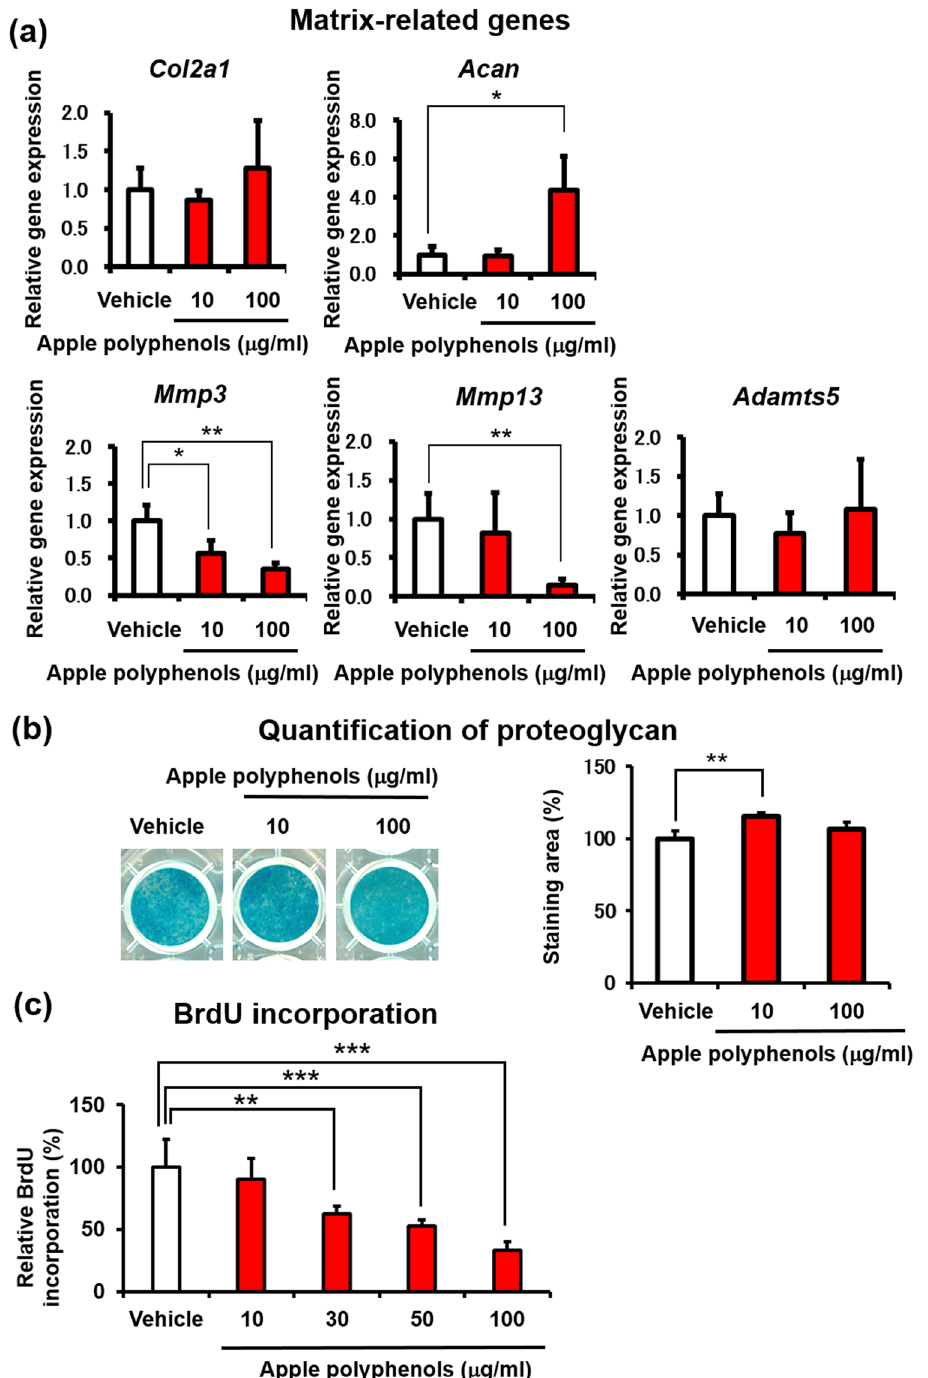
Figure 3. Apple polyphenols enhance proteoglycan synthesis in primary chondrocytes. Apple polyphenols were added to primary chondrocytes for 24 h for the assessment of their effects on the expression of matrix- related genes and BrdU incorporation, and for 14 days for the assessment of their effects on proteoglycan levels. ( a ) The expression profiles of matrix-related genes (n = 3), ( b ) proteoglycan levels (n = 3), ( c ) BrdU incorporation (n = 3). Values are the mean ± standard deviation ( * P < 0.05, ** P < 0.01, *** P < 0.001 versus control, Student’s t